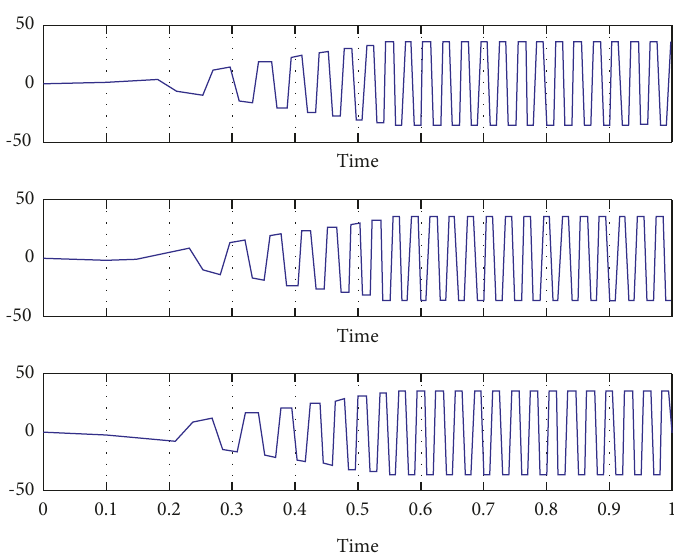
Figure 15: Stator back EMF e a , e b , and e c of the BLDC motor.